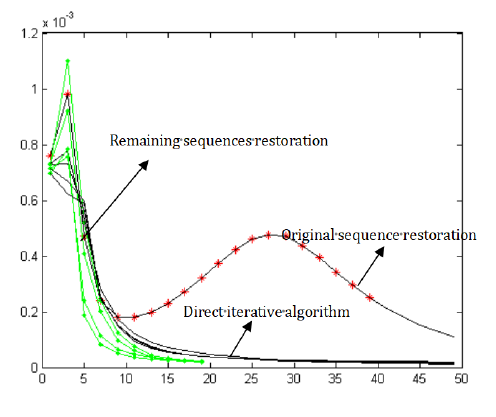
Figure 6. Iterations curve.